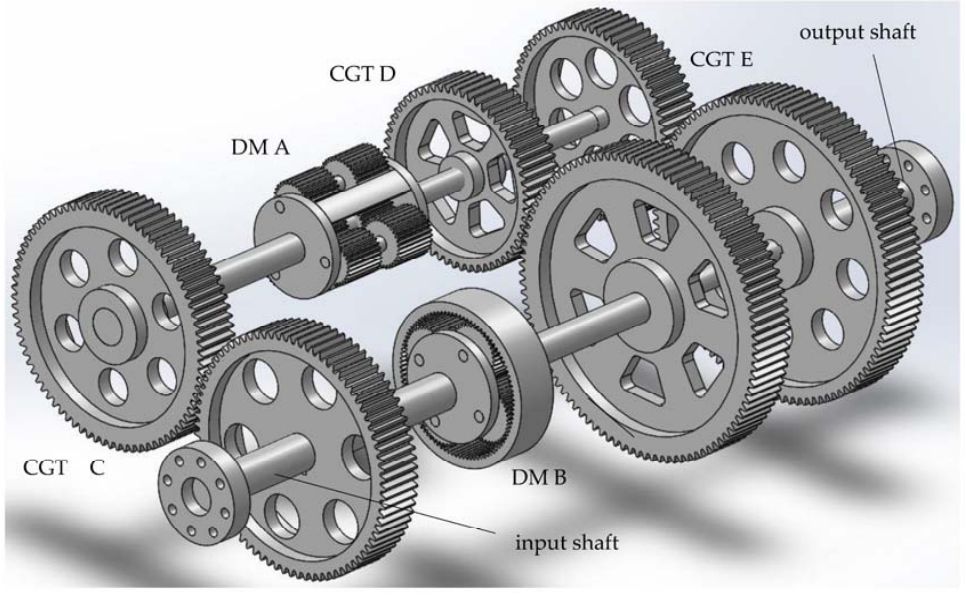
Figure 5. The sample transmission.